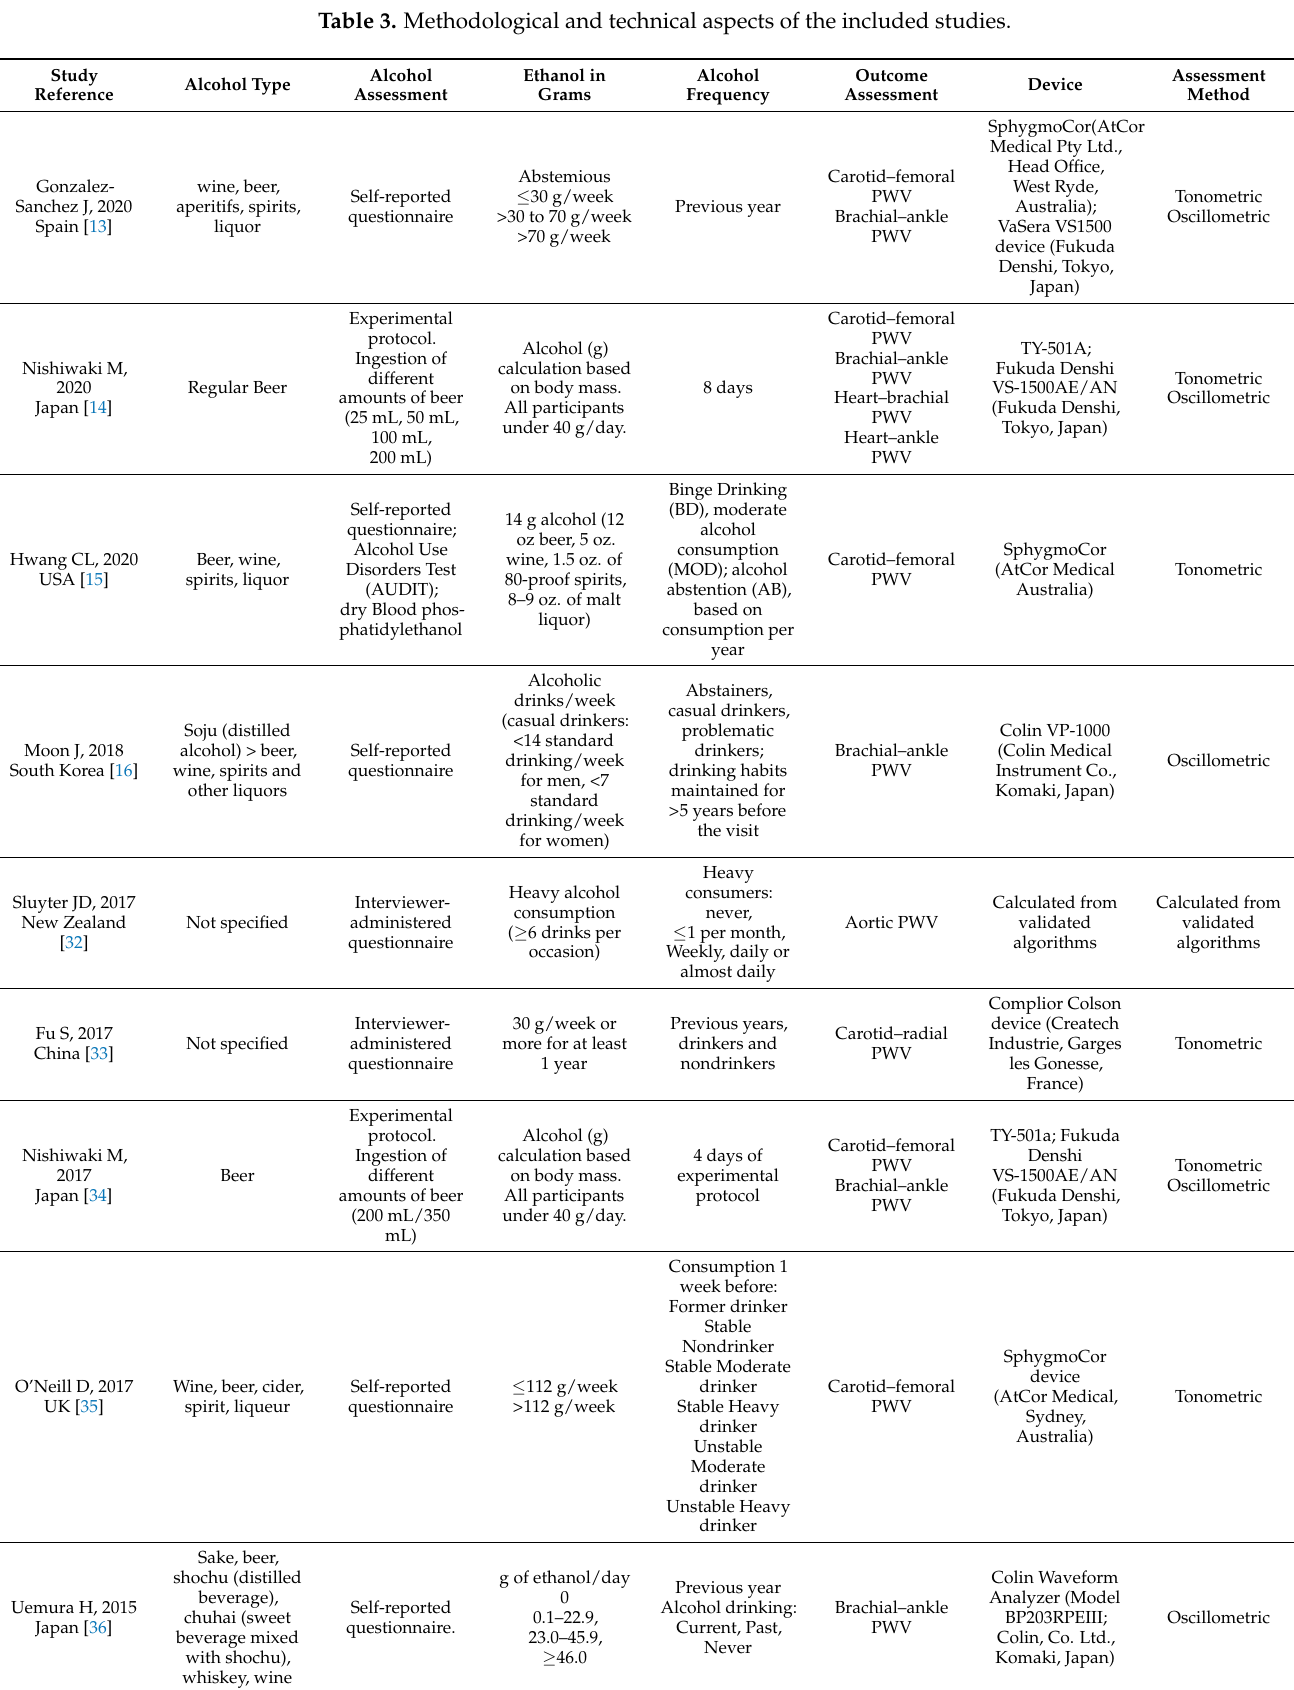
Table 3. Methodological and technical aspects of the included